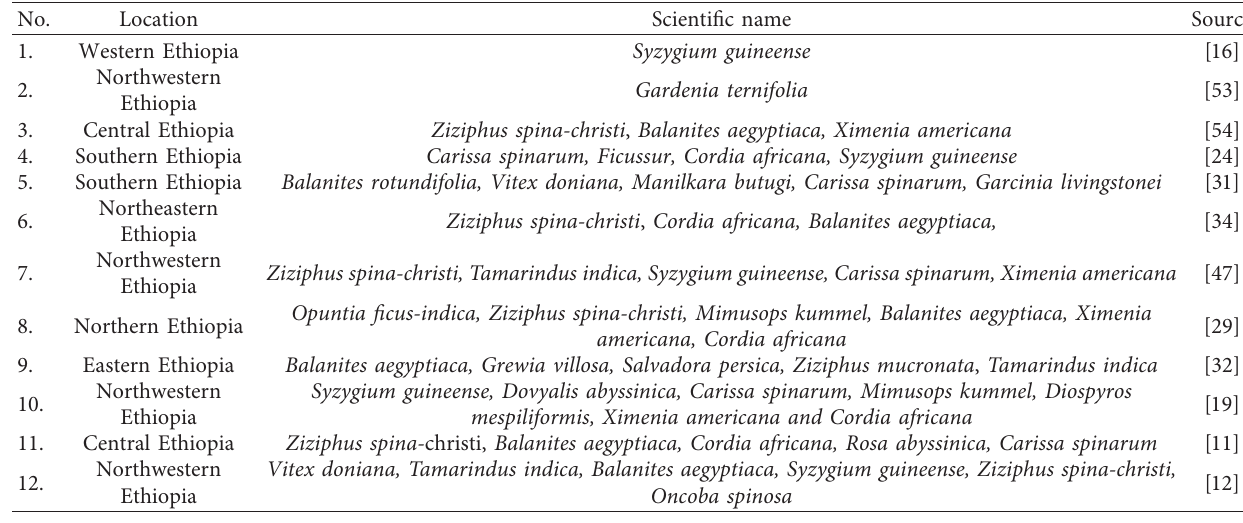
Table 4: Most preferred wild edible fruit species in Ethiopia.